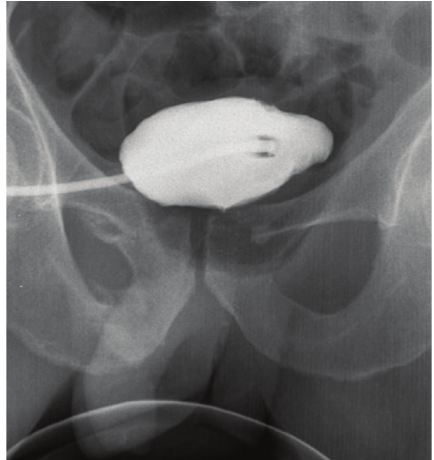
Figure 3: Control urethrocystography (2 weeks later). Examination performed with the patient supine. Contrast which is given through Pezzer catheter fills bladder without outflow. Urethra also has not been revealed on these